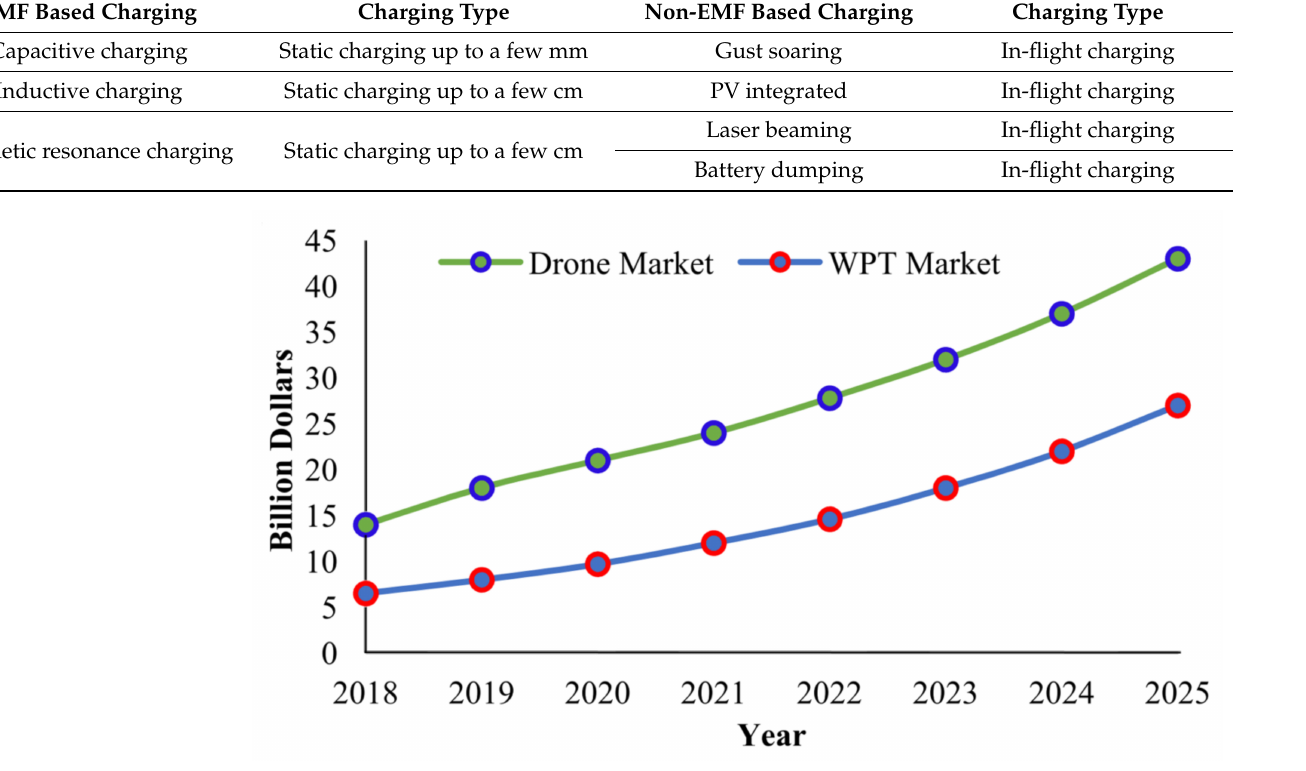
Figure 2. Statistics of Drones and WPT market growth